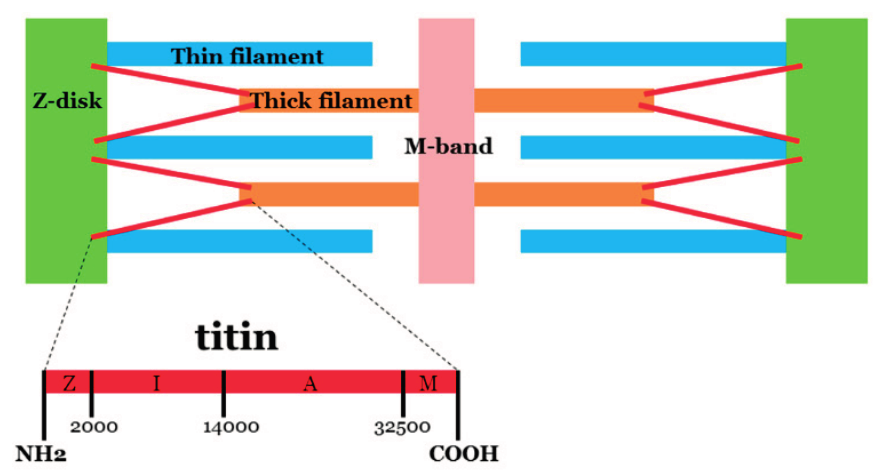
Figure 1. Representative diagram of titin’s position in myocyte architecture. Titin extends from the Z-disk of the sarcomere (N-terminus) to the M-band (C-terminus). The central part of the protein contains I-band region (I) and A-band region